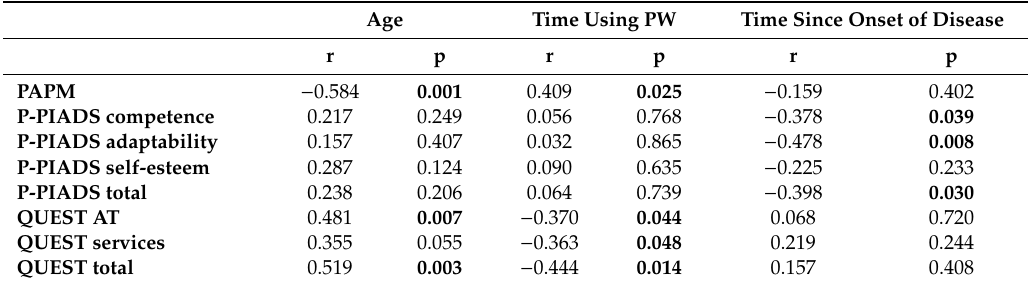
Table 4. Relation between PAPM, P-PIADS, QUEST and age, time using PW and time since onset of disease (n = 30).